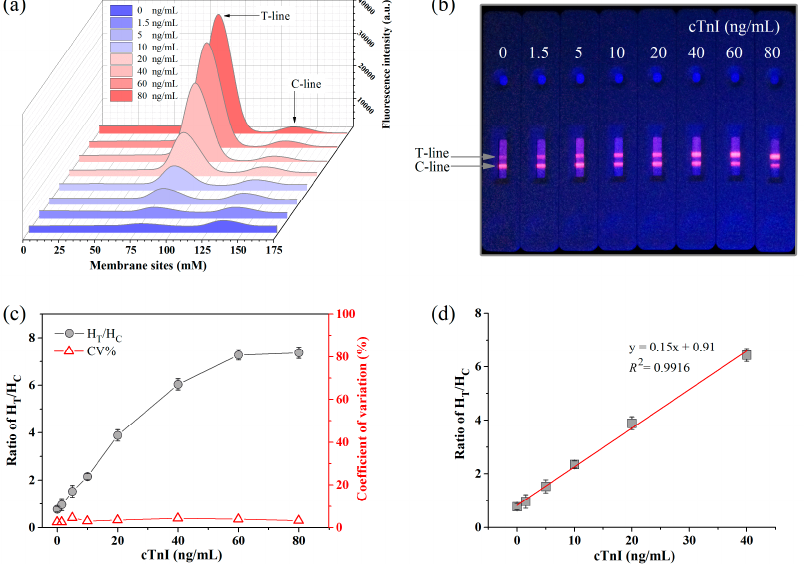
Figure 4. ( a ) The fluorescence signal intensity at different sites on the NC membrane at cTnI concentration from 0 to 80 ng/mL; ( b ) The photo of detection strips under UV-light; ( c ) The ratio of H T /H C and the corresponding coefficient of variations; ( d ) The standard curve of cTnI test.